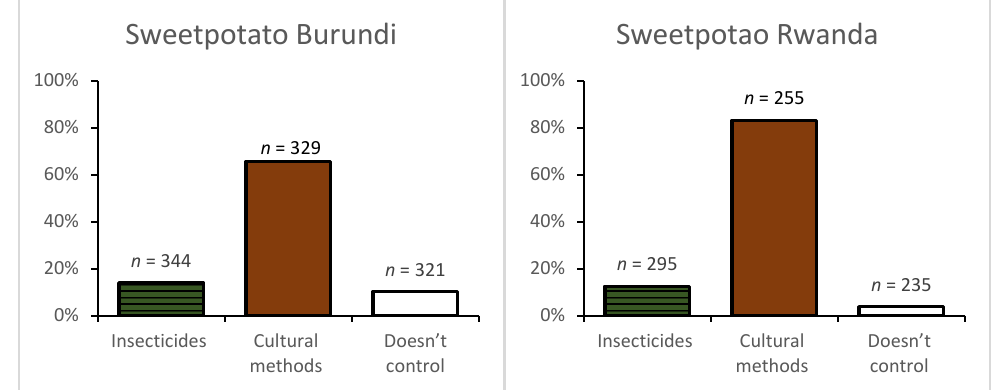
Figure 3. Pest and disease management practices used in sweetpotato in Rwanda and Burundi. Multiple responses were possible. n = number of responses.